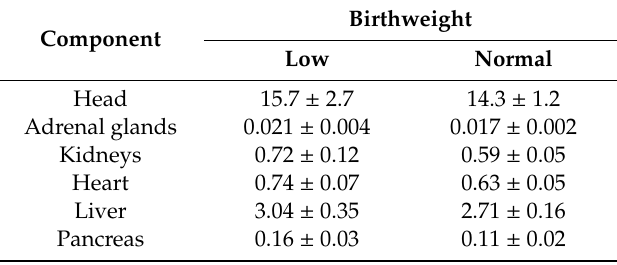
Table 2. Highlighted significant di ff erences ( p < 0.05) in relative weight to body weight (percentage) of di ff erent organs at 25 days old between piglets with low or normal